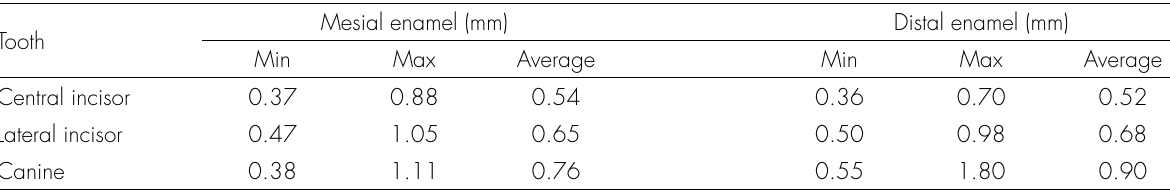
Table I. Enamel thickness of lower anterior teeth (adapted from Hudson, 1956 10